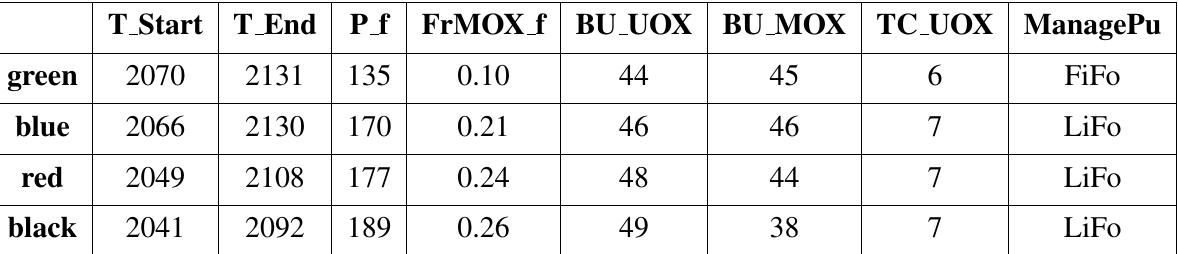
Table 3: Representative Reference Trajectories from clustering on